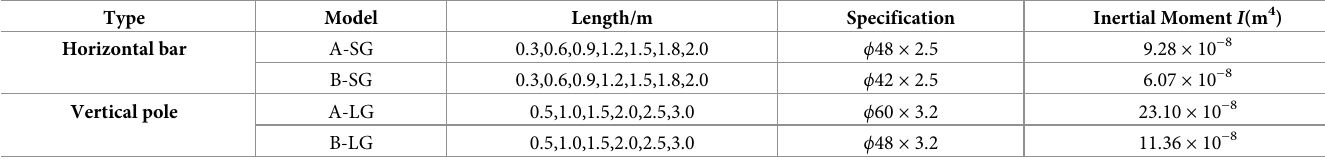
Table 1. Specification and section property of horizontal bars and vertical